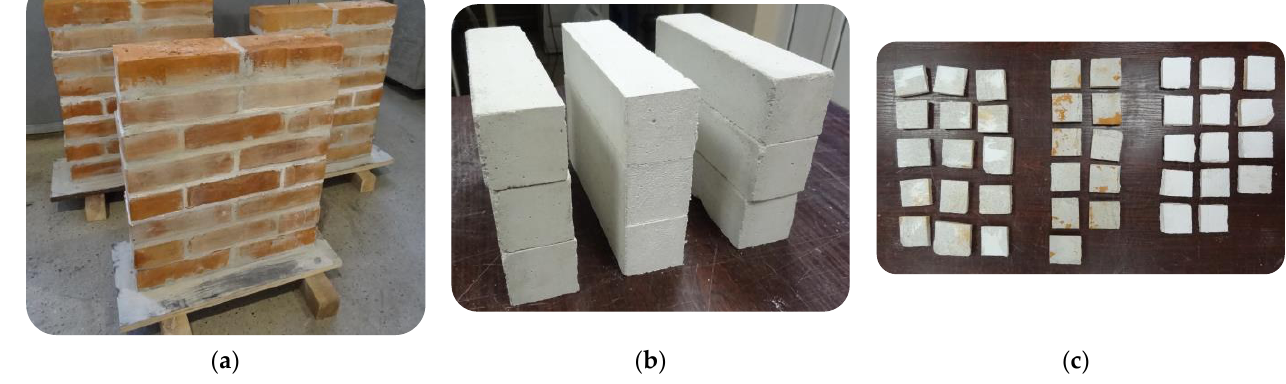
Figure 4. Tested elements: ( a ) brick masonry prisms; ( b ) standard specimens 4 × 4 × 16 cm 3 ; ( c ) DPT specimens ≈ 5 × 5 cm 2 .